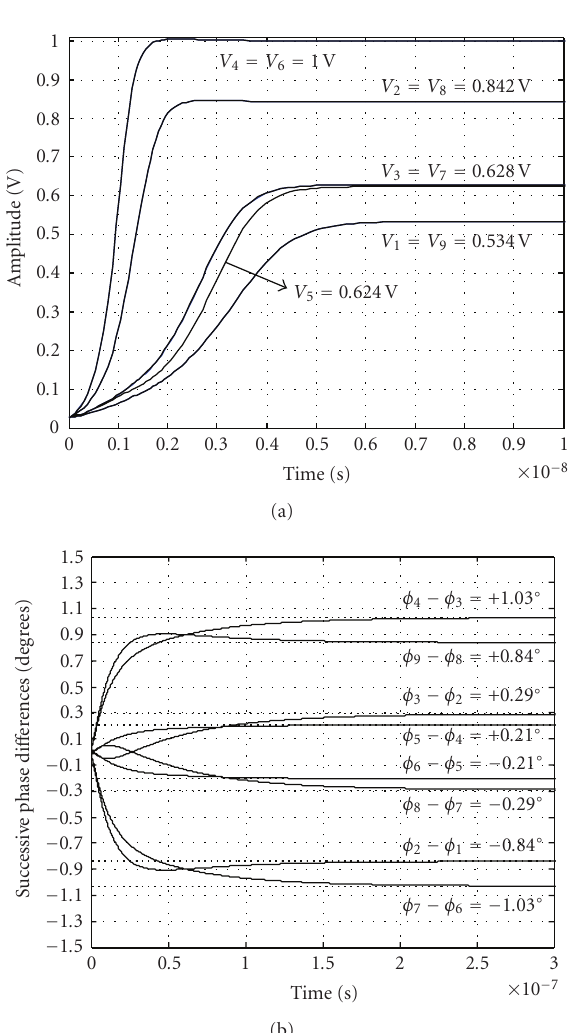
Figure 5: The coupled oscillator array response evolution with time for the general design case. (a) The evolution of the amplitudes. (b) The evolution of the phases.